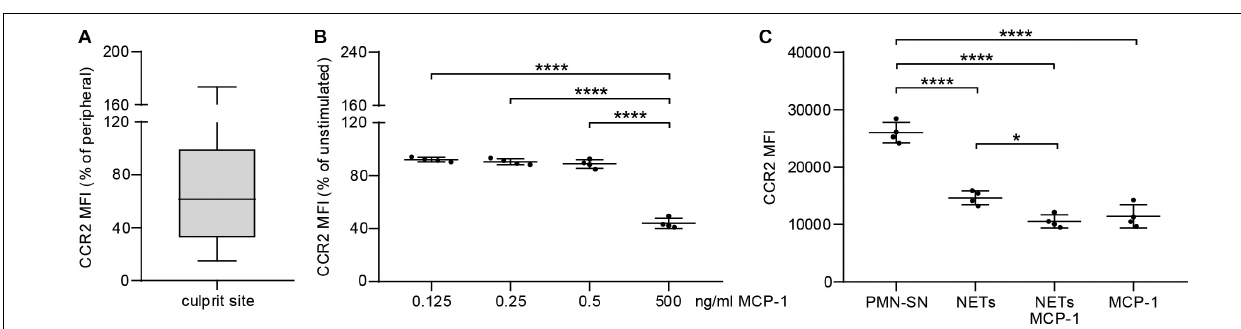
Frontiers in Cell and Developmental Biology | www.frontiersin.org